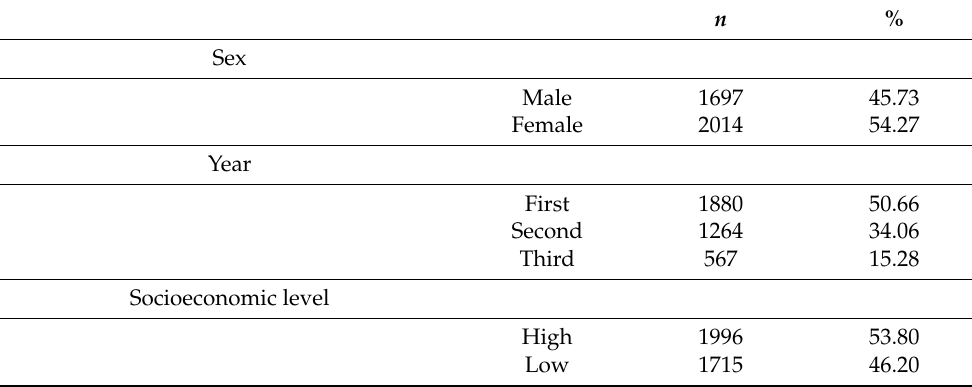
Table 1. The demographic characteristics of the study